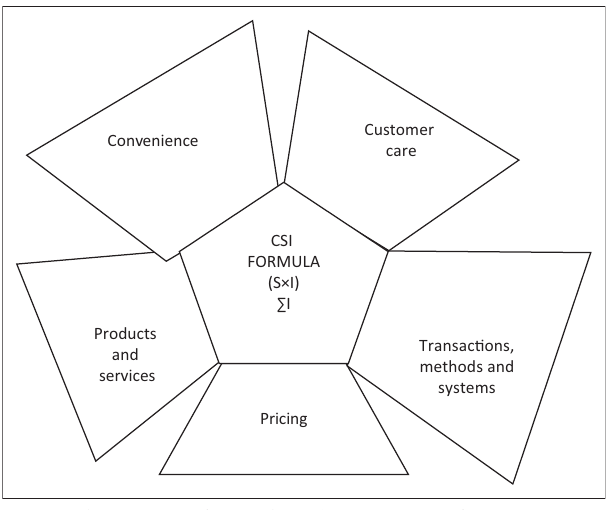
FIGURE 1: Customer service factors. S, satisfaction; I, importance; CSI, Customer Satisfaction Index.